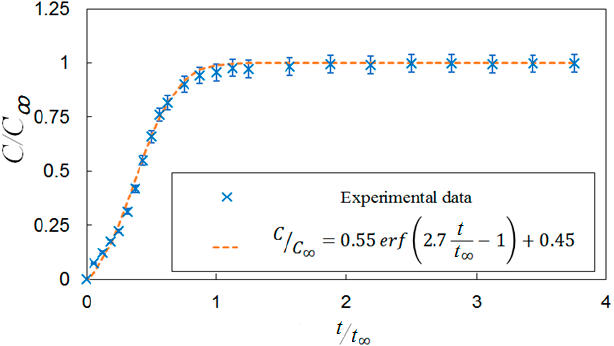
Figure 8. A correlation for the temporal evaluation of the dye concentration under bubble-induced mixing without vertical vibration.